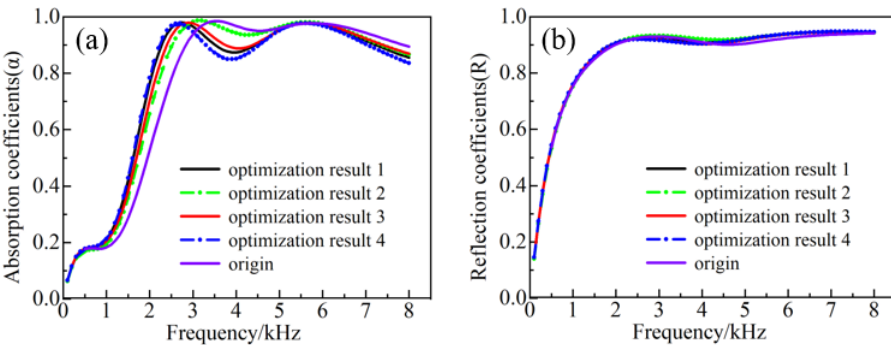
Figure 12. Optimization results for ( a ) forward absorption and ( b ) backward reflection. Table 2. Model optimization parameters.